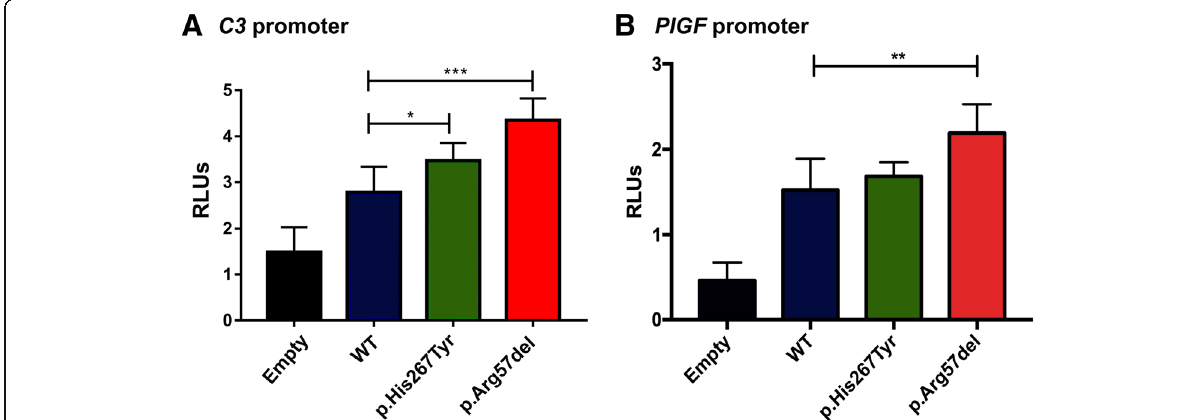
Fig. 1 Transactivation properties of FOXD1-WT and mutant versions on C3 and PlGF promoters. The FOXD1-WT version overexpression allowed to transactivate the C3 and PlGF promoters in luciferase gene reporter assays (C3: WT vs empty vector, 1.9-fold, p = 0.0024; PlGF: WT vs empty vector, 3-fold, p = 1.3 × 10 − 5 ) ( a and b panels). a Compared to that of the WT version, the FOXD1 p.His267Tyr and p.Arg57del mutations increased significantly C3 transcriptional activity (1.25-fold, p = 0.03 and 1.5-fold, p = 0.0004, respectively). b The FOXD1-p.Arg57del mutation increased PlGF transcriptional activity (1.4 fold, p = 0.002) compared to that for the FOXD1-WT counterpart. RLU: relative luciferase units. (*): p < 0.05; (***): p <